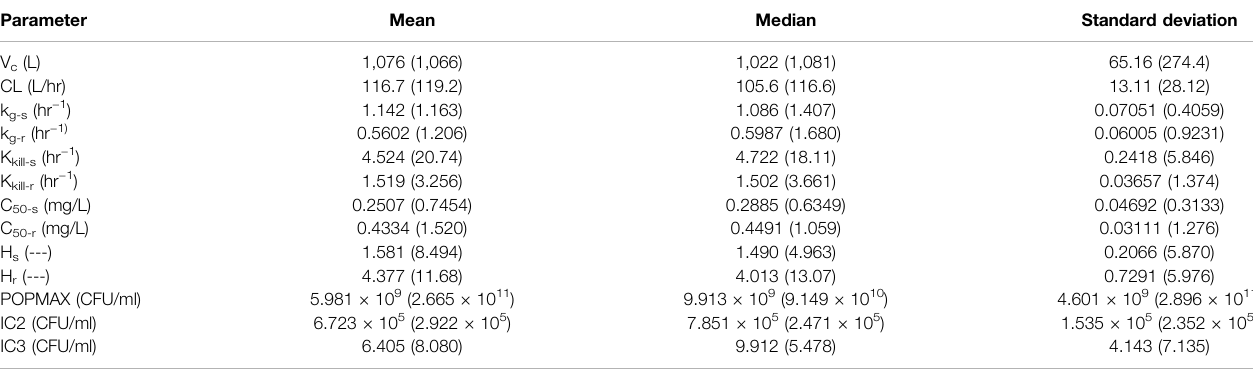
TABLE2| Mean,median,andstandarddeviationoftheparametervaluesforthehollow fi berinfectionmodel(HFIM)studywith Neisseriagonorrhoeae referencestrainsWHO F (WHO X). Parameter